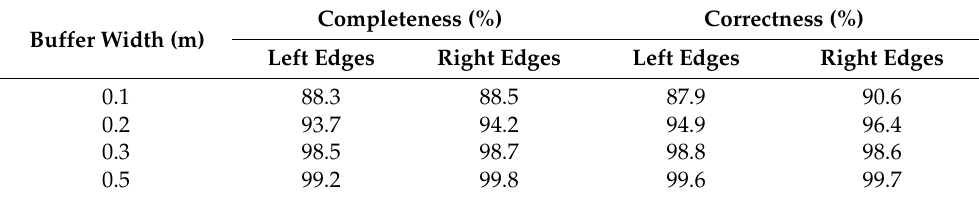
Table 4. Completeness and correctness at two study